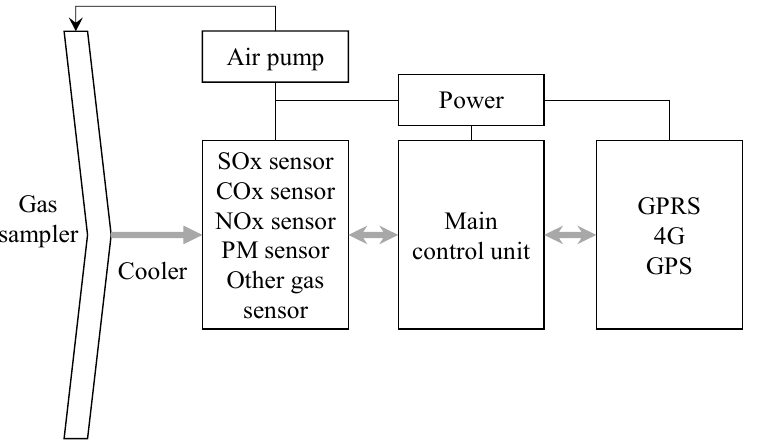
Figure 5. A module of emission sensors.